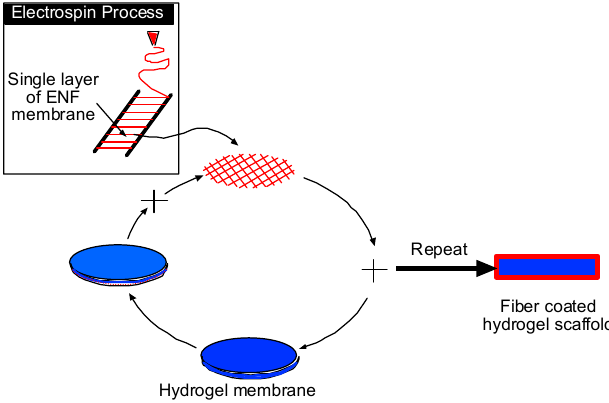
Figure 1. Schematic representation to produce a nanofiber-coated hydrogel scaffold.